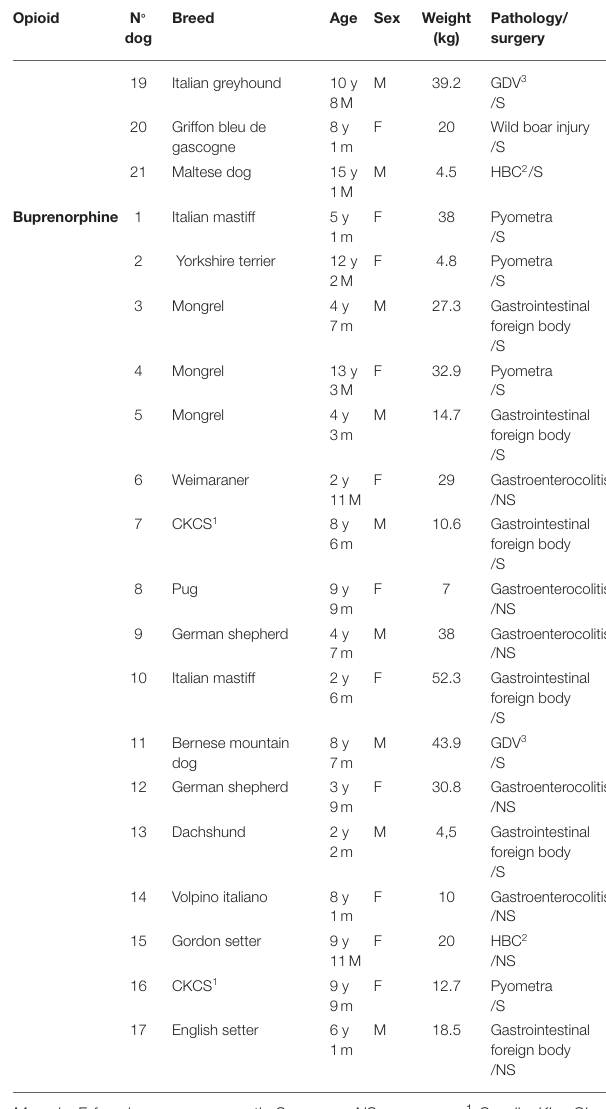
Breed Age Sex Weight dog